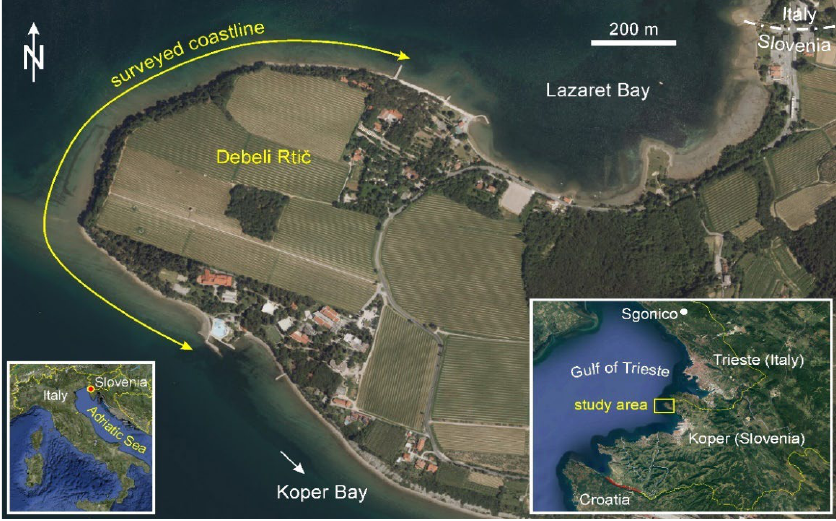
Figure 1. Location of the Debeli Rt ič promontory. The surveyed rocky coastline is indicated.